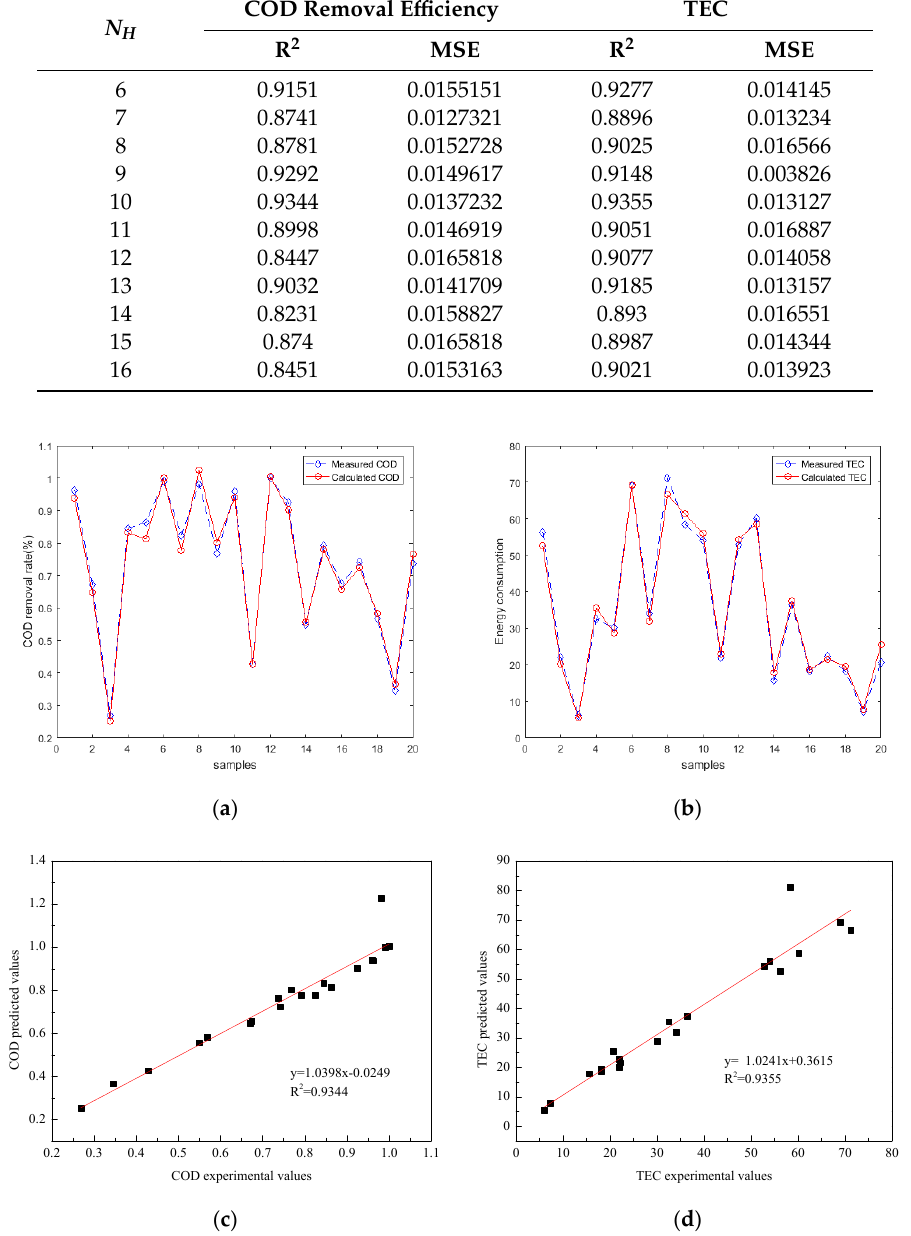
Figure 5. Performance of the BP–ANN predicting COD removal e ffi ciency and TEC between experimental and predicted data sets (COD removal e ffi ciency testing set ( a ), TEC testing set ( b )); correlations between experimental and predicted set (COD removal e ffi ciency testing set ( c ), TEC testing set ( d